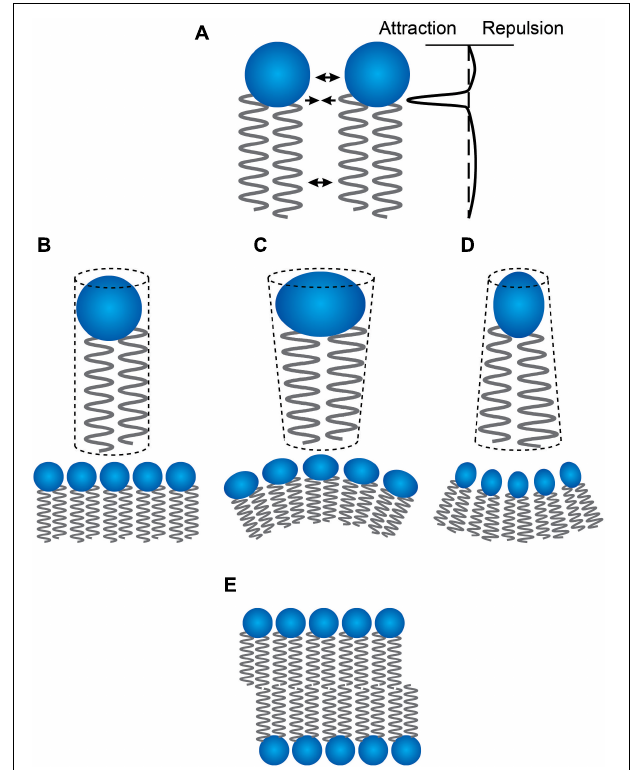
FIGURE 1 | Lipid “shape” and curvature. (A) the profile of intermolecular interactions between two lipid molecules in a bilayer. Changes in this profile alter the effective lipid “shape” and the intrinsic curvature, c 0 , of the bilayer-forming lipids. (B) Lipids that have a cylindrical shape form plane monolayers with no intrinsic curvature. (C) Increased repulsion between the head groups will cause the lipids to be cone-shaped with the broad base toward the aqueous solution—and to form monolayers with a positive curvature (the surface is convex when viewed from the aqueous solution). (D) Decreased repulsion between the head groups will cause the lipids to be cone-shaped with the broad base toward the terminal methyl groups—and to form monolayers with a negative curvature (the surface is concave when viewed from the aqueous solution). (E) As long as the curvature is not too extreme, all three types of lipids can form planar bilayers—with the bilayers formed by lipids having intrinsic curvature being under a curvature frustration stress, which will contribute the energetics of channel formation (the energetic cost of a channel-imposed bilayer thinning will decrease as c 0 increases and increase as c 0